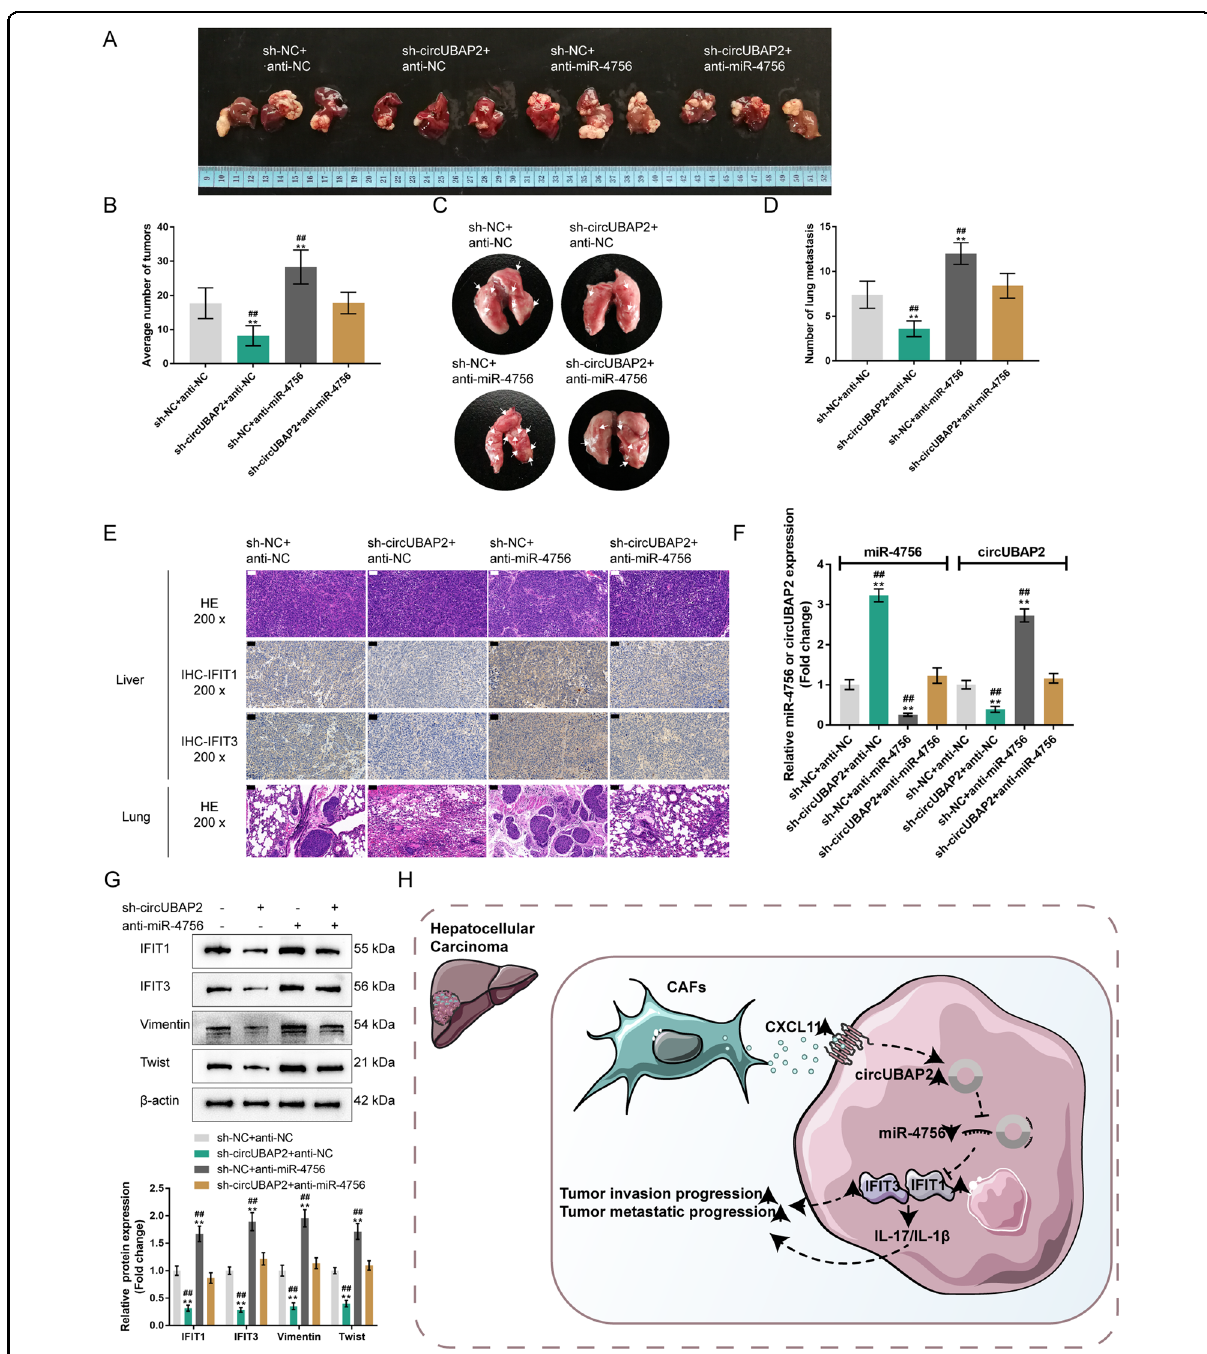
Fig. 8 Combined effects of circUBAP2 and miR-4756 on tumor growth and lung metastasis in the orthotopically implanted tumor model in BALBc nude mice. A , C The orthotopic implantation tumor model was conducted by injecting Huh-7 cells coinfected with sh-NC/sh-circUBAP2 and anti-NC/anti-miR-4756 lentivirus into the left liver lobe of mice. After 5 weeks, anesthetized mice were sacri fi ced and livers and lungs were collected for further experiments. B Tumor numbers in mice livers from different groups were counted. D Lung metastatic nodules in mice from different groups were counted. E The histopathological characteristics of mice livers and lungs were evaluated by H&E staining. The protein content and distribution of IFIT1/3 in mice liver tumors were examined by IHC staining. F The expression levels of circUBAP2 and miR-4756 in mice livers from different groups were examined by qRT-PCR. G The protein levels of IFIT1/3, Vimentin, and Twist in mice livers tumors from different groups were examined by Immunoblotting. H A schematic graph of the mechanism. CXCL11 acts as a key mediator integrating CAFs and CAFs-cohabitating HCC cells, and also work as an extracellular remodeler promoting HCC migration and metastasis through the activation of circUBAP2/miR-4756/IFIT1/3 in tumor cells. ** P < 0.01, compared with the sh-NC + anti-NC group; ## P < 0.01, compared with the sh-circUBAP2 + anti-miR-4756